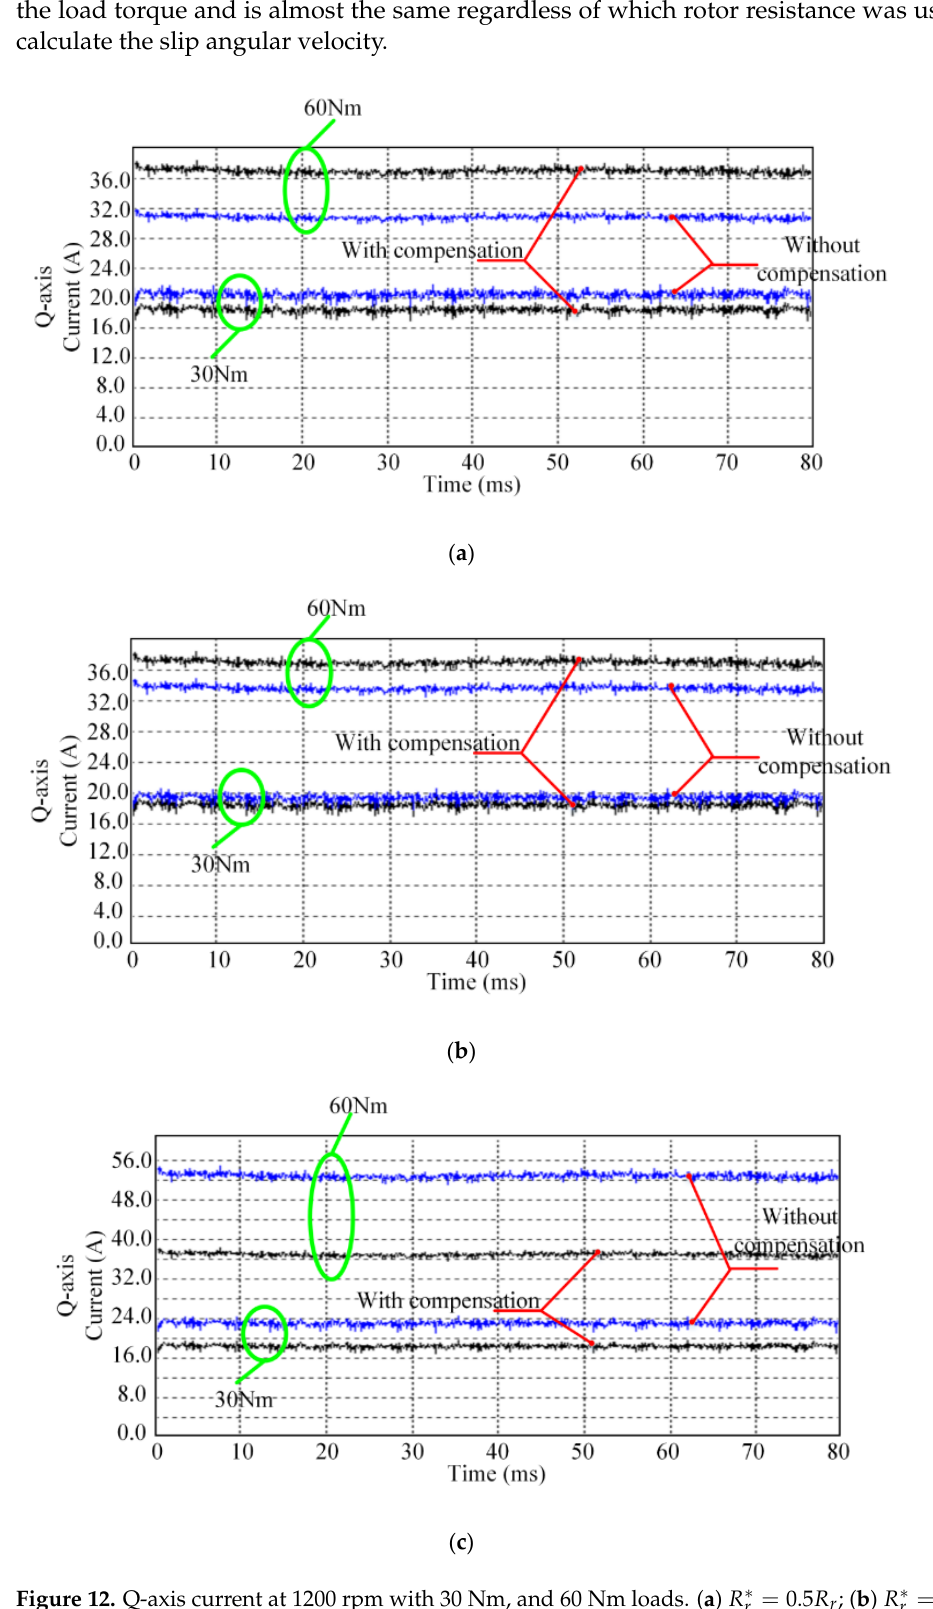
Figure 12. Q-axis current at 1200 rpm with 30 Nm, and 60 Nm loads. ( a ) R ( c ) R ∗ r = 1.5 R r